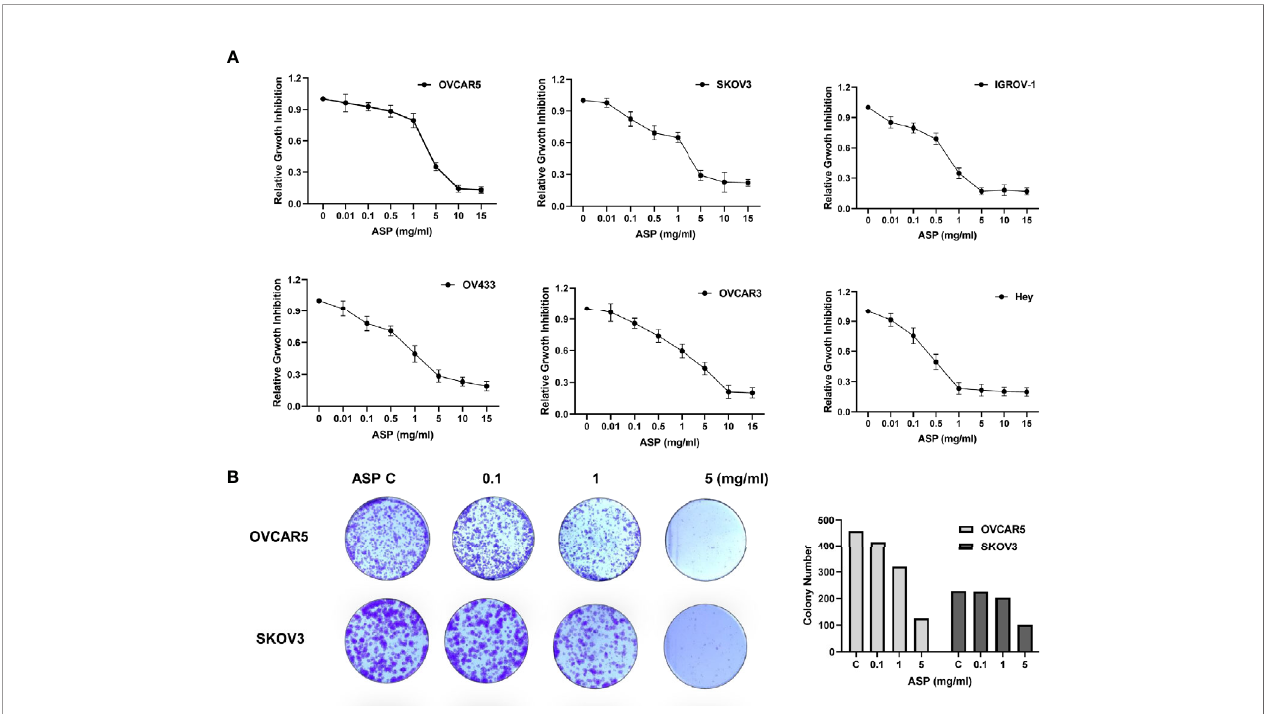
FIGURE 1 | ASP inhibited OC cell proliferation and colony formation. The OVCAR5, OVCAR3, Hey, OV433, IGOV-1 and SKOV3 cell lines were treated with different concentrations of ASP in 96-well plates for 72 hours. Cell proliferation was assessed by MTT assay. ASP suppressed cell proliferation in a dose-dependent manner in OC cells (A) . The effect of ASP on the long-term growth of the OVCAR5 and SKOV3 cell lines was assessed through a colony-forming assay. ASP inhibited colony formation in both cell lines after 12 days of treatment (B) . All data are presented as mean ± SE of triplicate samples and are representative of three independent